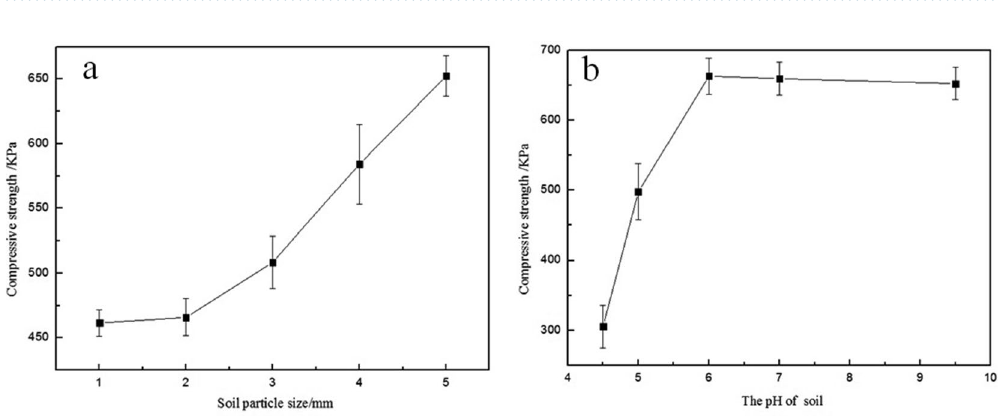
Figure 6. Effect of blending conditions on compressive strength of consolidated soil columns. ( a ) General conditions: Stirring time-40 min; Content of KGM, CA, PVA = 4.0%, 4.0%, 5.0%; pH of glue-4.5; pH of the Cinnamon soil-8.5; soil particle size-2 mm; ( b ) General conditions: Stirring time-40 min; T-85 ℃ ; Content of KGM, CA, PVA = 4.0%, 4.0%, 5.0%; pH of the Cinnamon soil-8.5; soil particle size-2 mm; ( c ) General conditions: Stirring time-40 min; T-85 ℃ ;KGM:CA = 1:1; Content of PVA-5.0%; pH of glue-4.5, pH of the Cinnamon soil-8.5; soil particle size-2 mm.